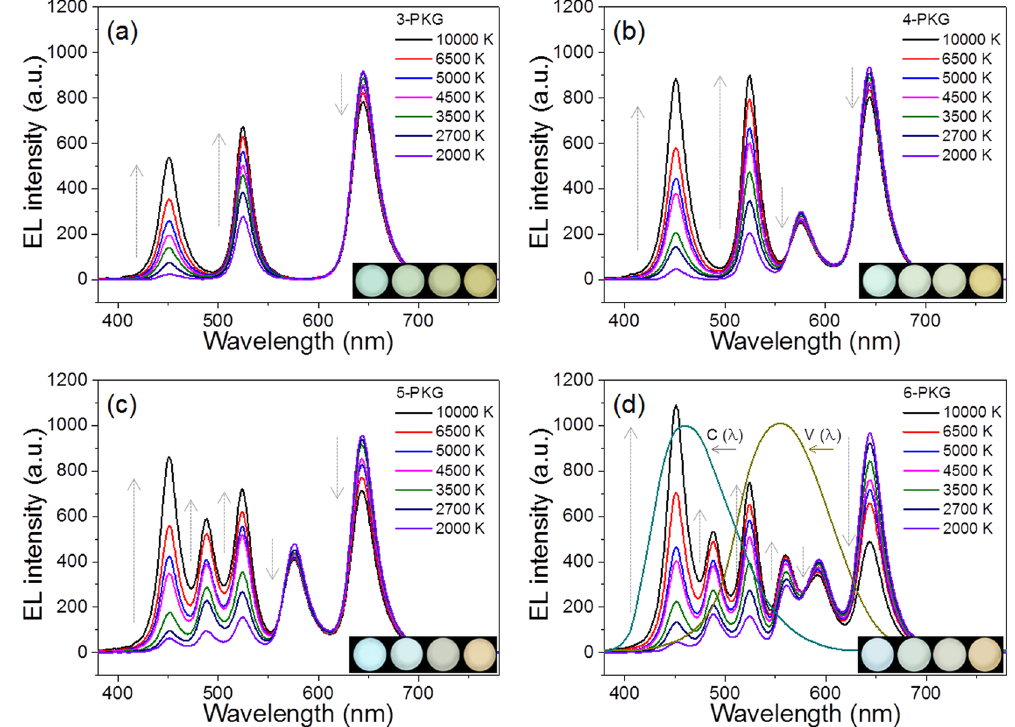
Figure 4. EL spectra of ( a ) three-, ( b ) four-, ( c ) five-, and ( d ) six-package white LEDs in a white CCT ranging between 10000 K to 2000 K. The gray arrows indicate an increase or a decrease of the EL intensity level with an increase in the CCT. The cyan and dark yellow spectra refer to the circadian spectral function [C( λ )] and the photopic spectral function [V( λ )], respectively. Insets show actual emission images of each multi-package white light from a black-body sphere with an increase in CCT from right (3500 K) to left (6500